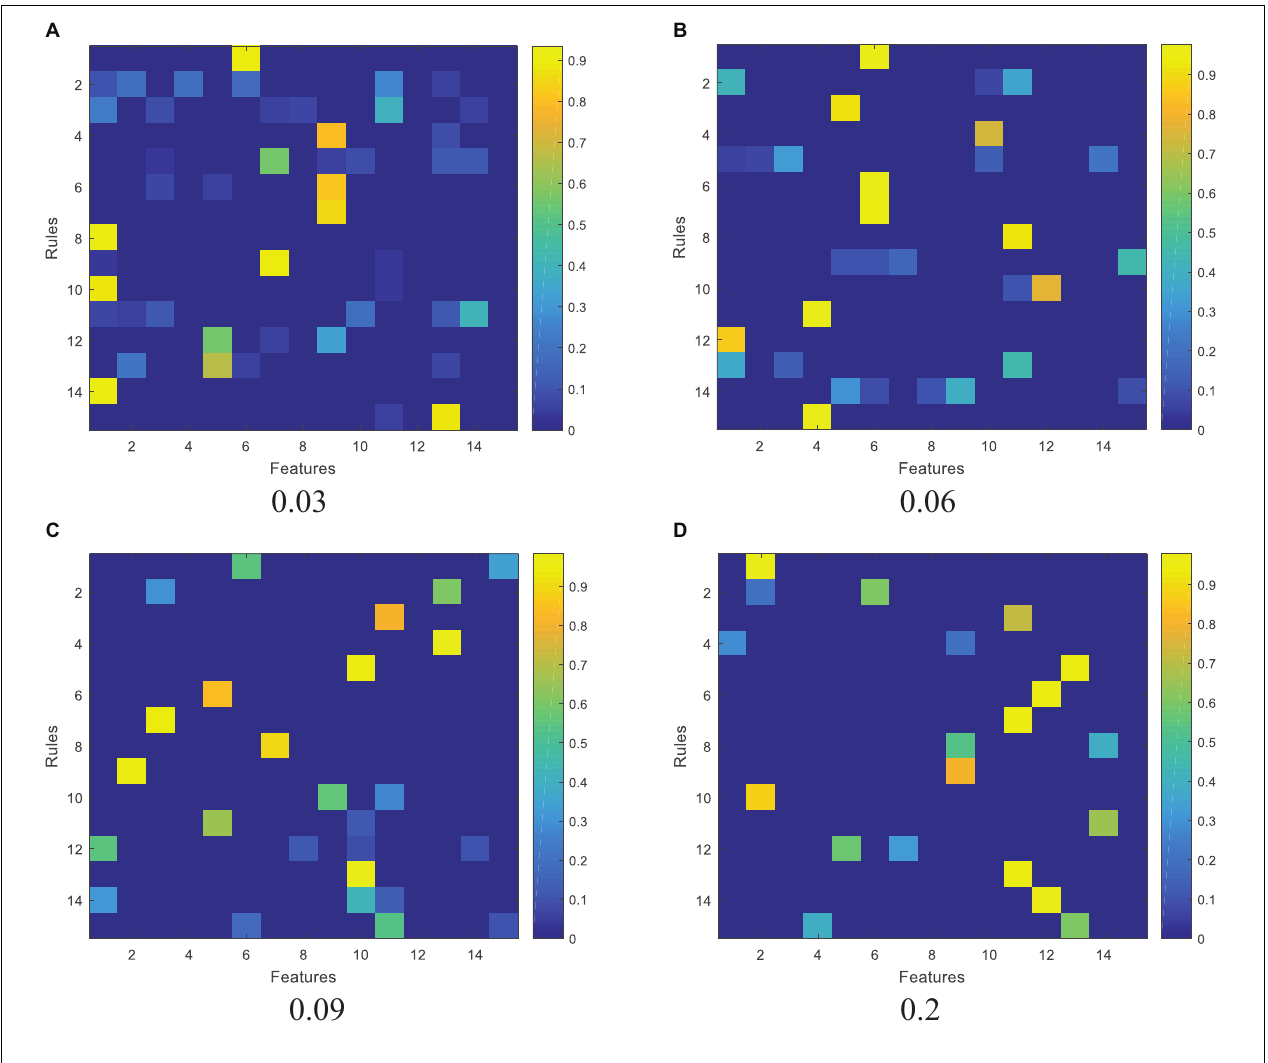
FIGURE 3 | Activation of features by the subspace clustering under different thresholds: (A) 0.03, (B) 0.06, (C) 0.09, and (D)